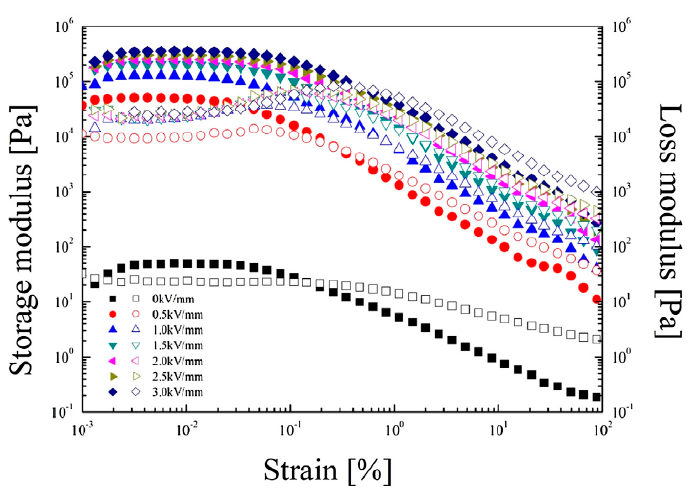
Figure 9. Storage modulus (filled symbols) vs. strain and loss modulus (open symbols) vs. strain for the phosphate MCC ER fluid under a series of external electric field strengths (reprinted from [70]).